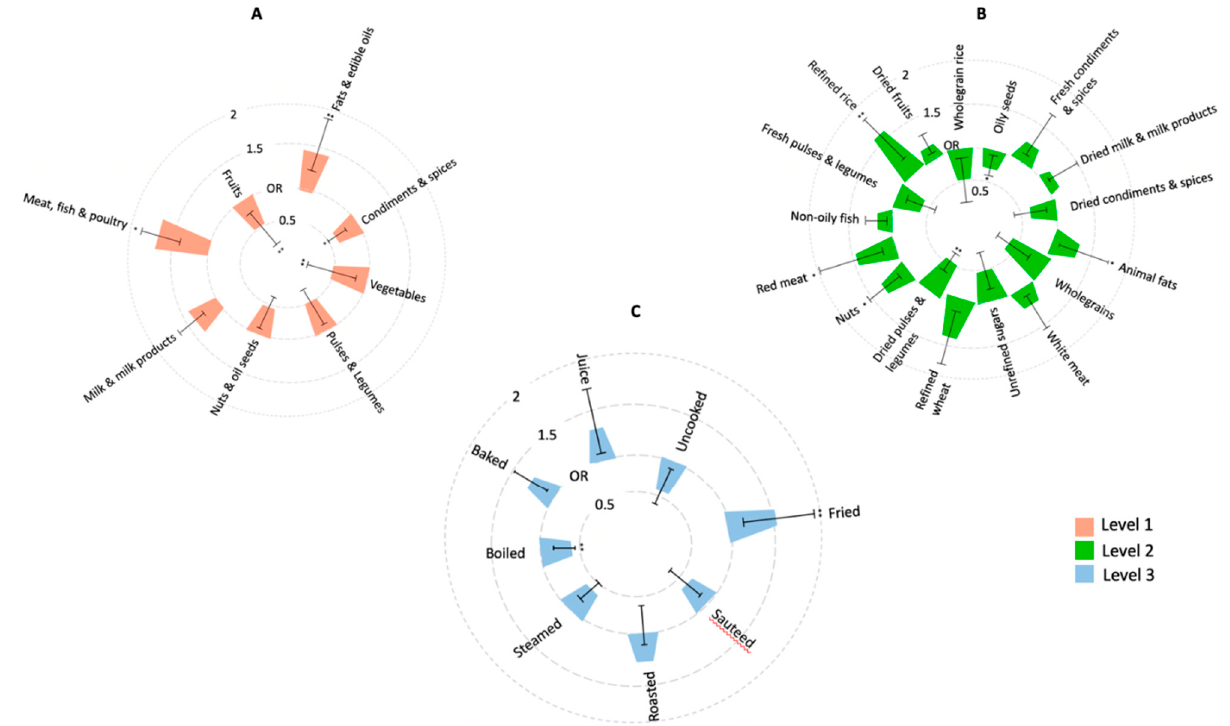
Table 3. Comparison of mean intakes of individual food groups and their associations with degree of fibrosis based on liver stiffness measurements.